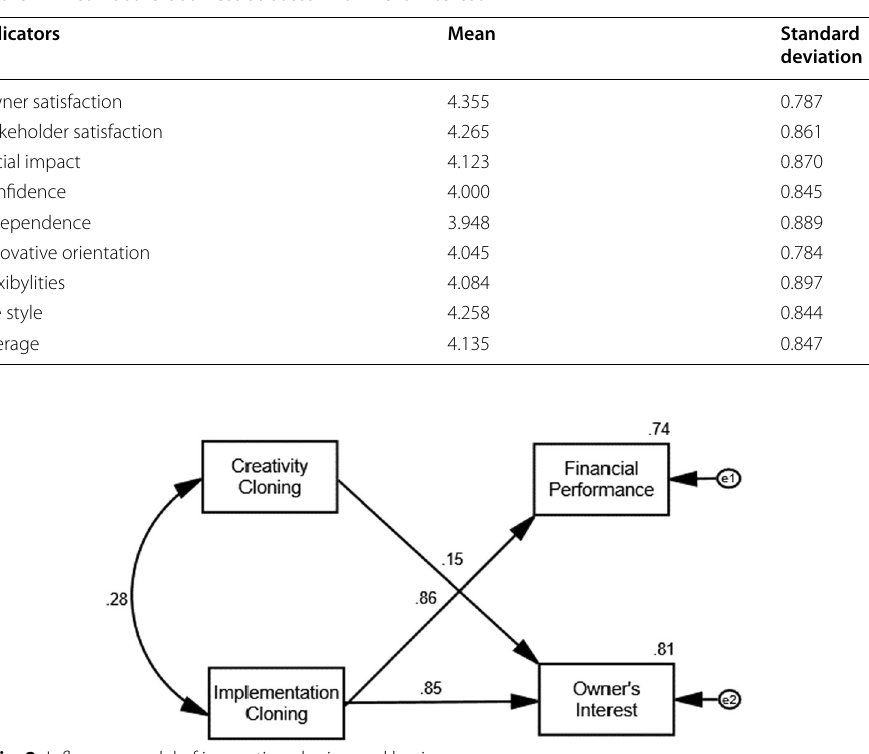
Fig. 2 Influence model of innovation cloning and business success